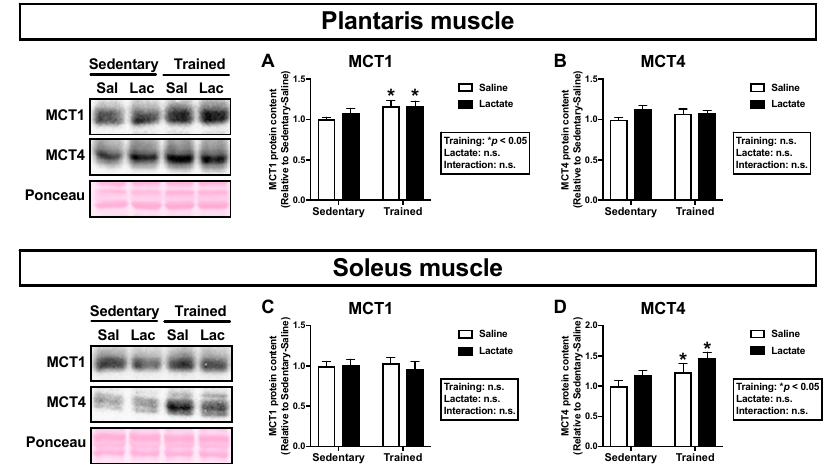
Figure 3. Protein contents of MCT1 ( A , C ) and MCT4 ( B , D ) in the plantaris muscle ( A , B ) and the soleus muscle ( C , D ) following 4-week lactate ingestion. Data are presented as means ± SEM ( n = 8–9). * p < 0.05: main effect of endurance training.